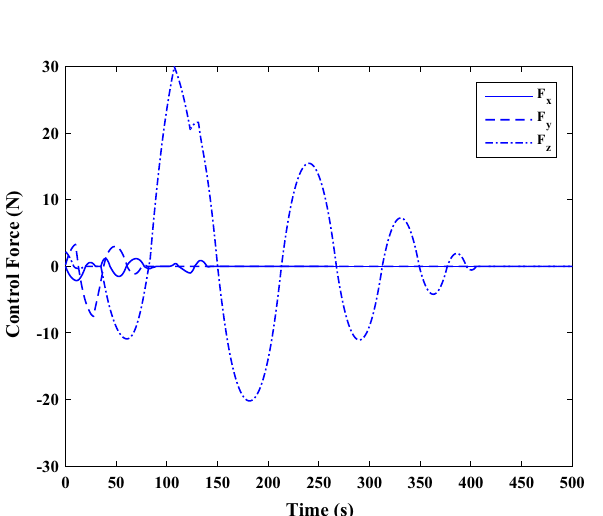
Figure 46. Scenario II: relative position error (in chaser body frame).